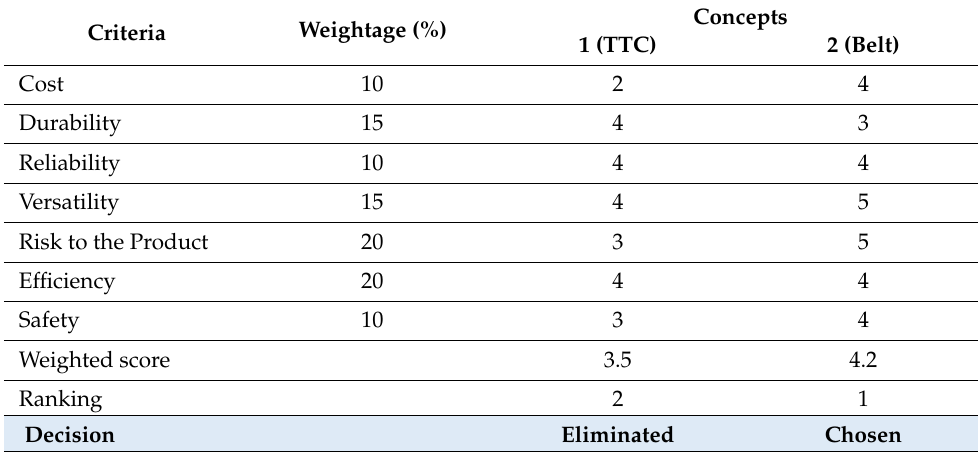
Table 10. Summary of the concept scoring results in Concepts 1 and